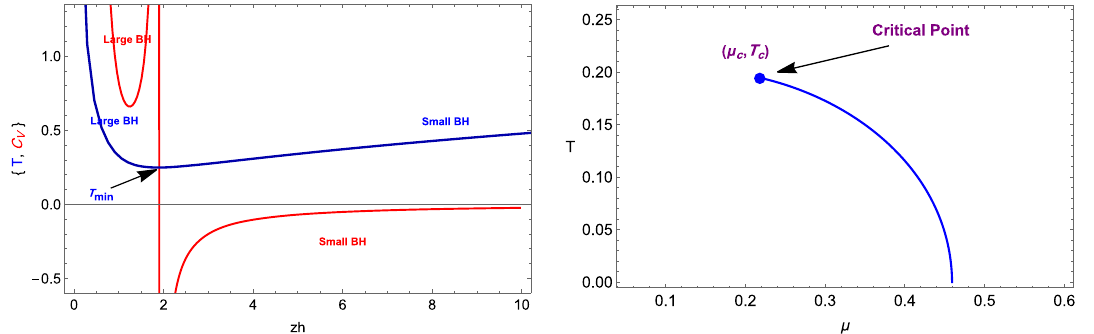
Fig. 3 Left: Temperature T (blue line) and heat capacity C V (red line) of the black hole as a function of the horizon radius z h . For both plots, we have fixed the value of charge as q = 0 . 9. Right: Temperature of